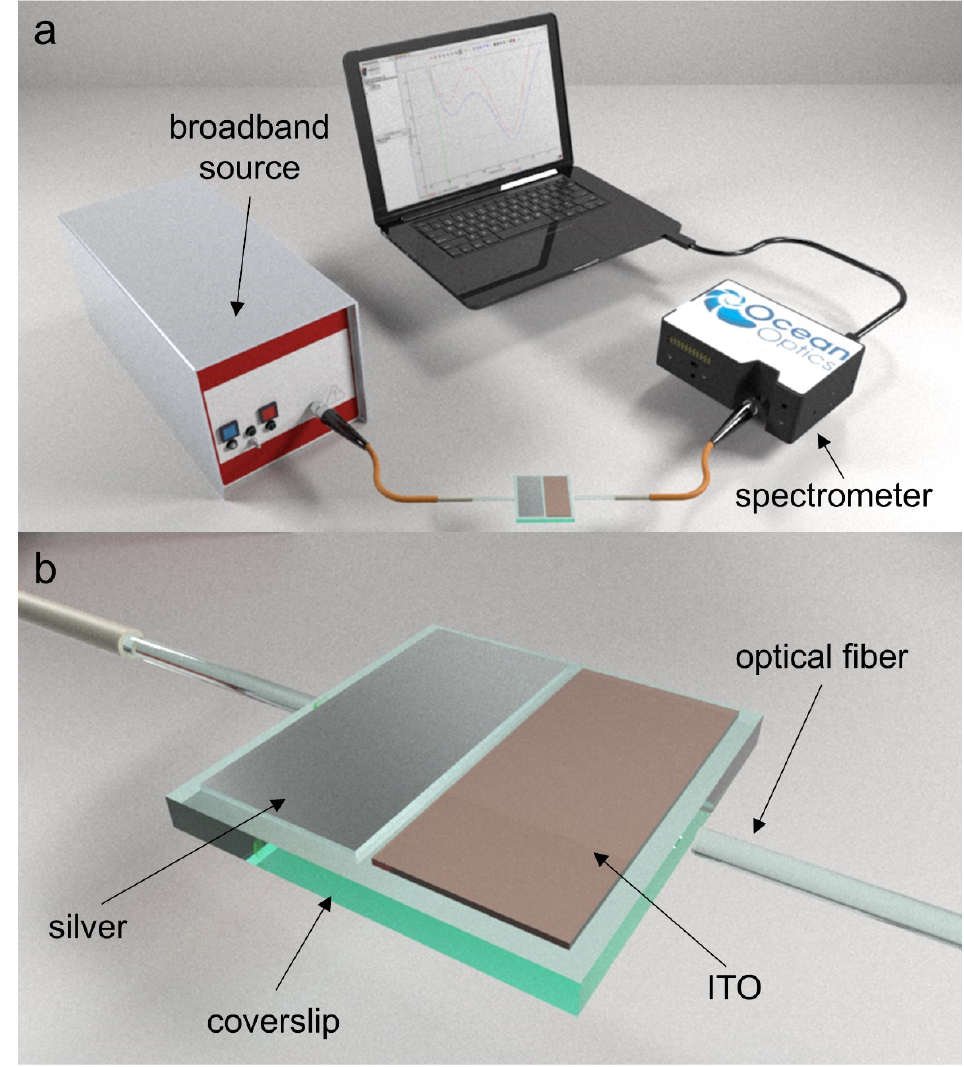
Figure 2. ( a ) Experimental setup. ( b ) Coverslip nanocoated with silver and ITO